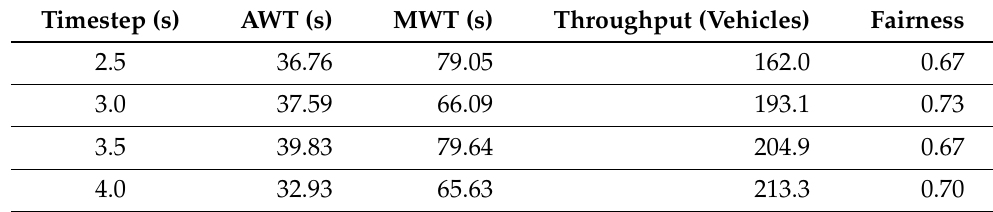
Figure 11. Maximum Wait Time with α = 15 and different β . Table 6. Average performance comparison with different action time